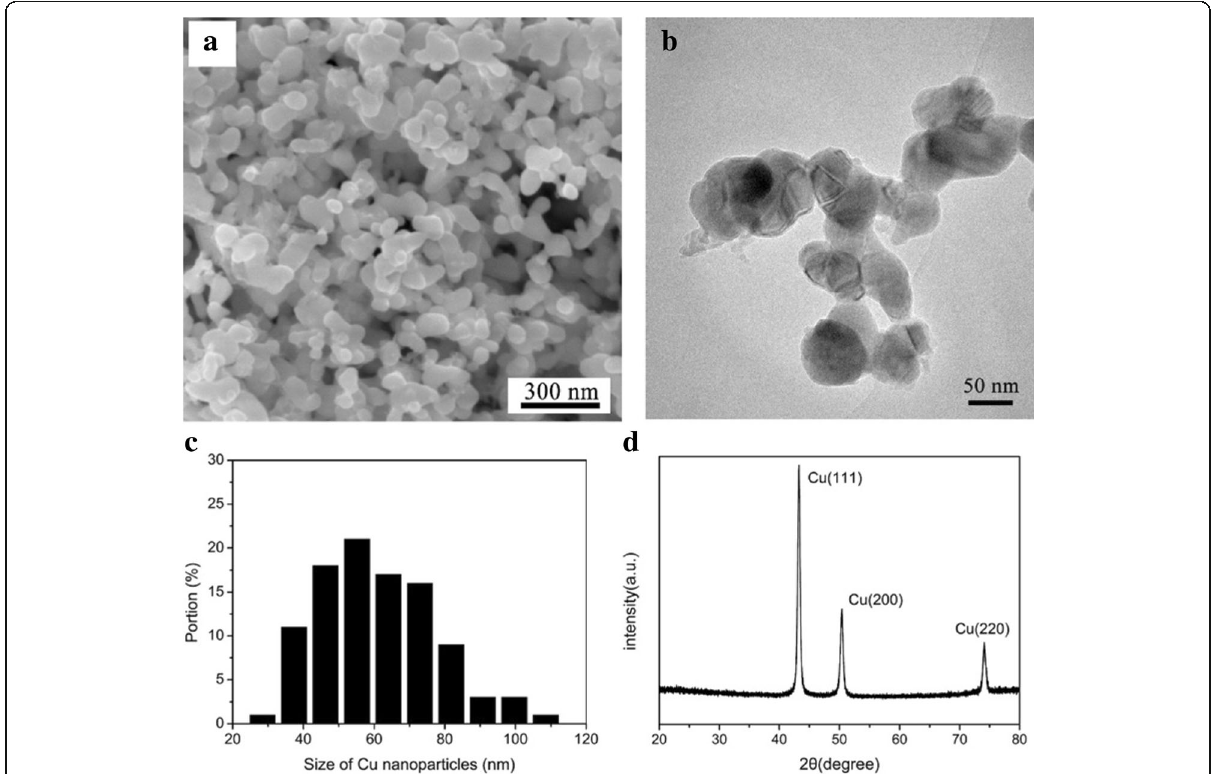
Fig. 1 a The SEM image, b the TEM image, c the size distribution and d the XRD patterns of the synthesized Cu